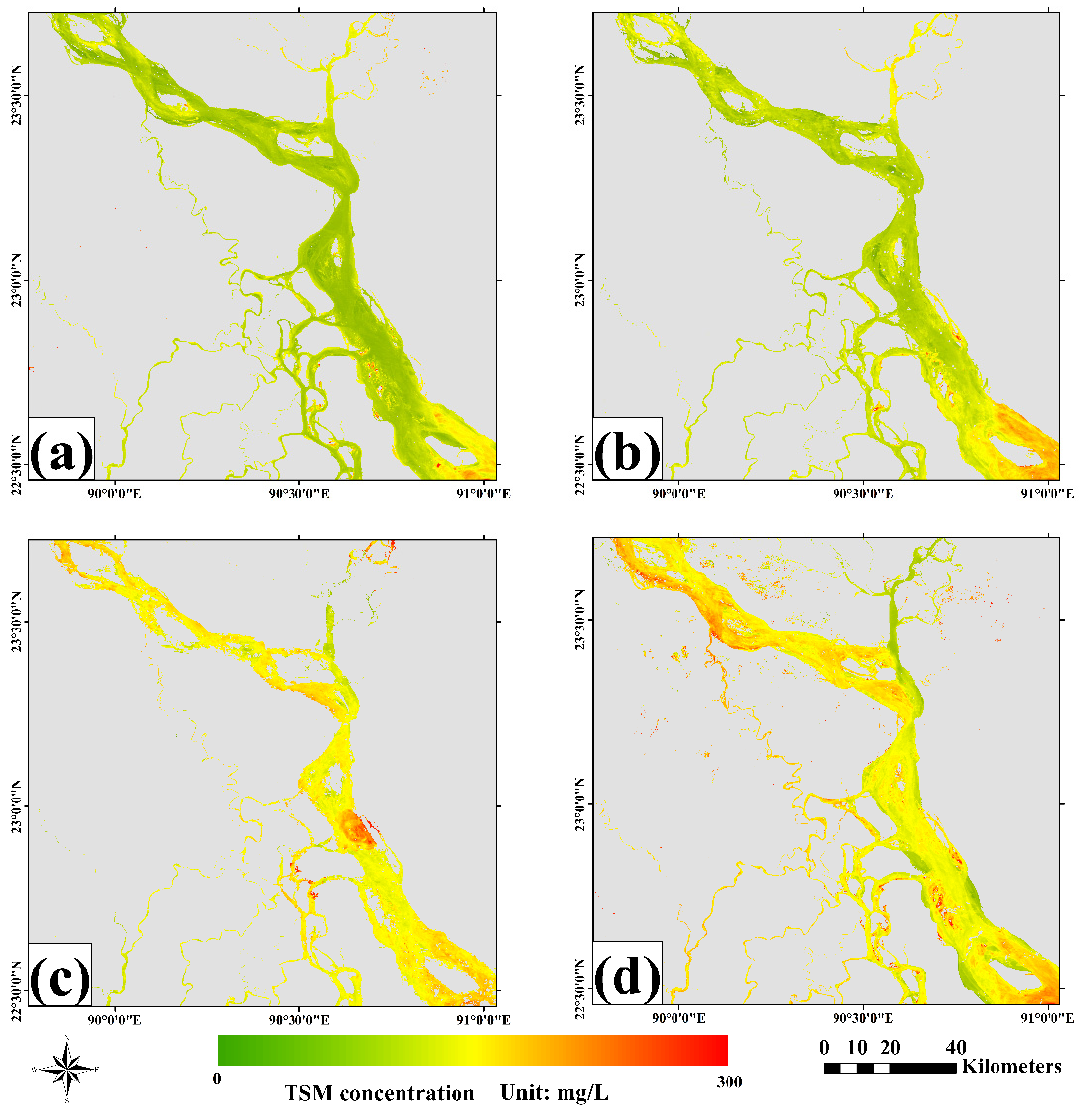
Figure 6. Distribution of C TSM in the Padma River in: ( a ) winter, ( b ) spring, ( c ) summer, and ( d )